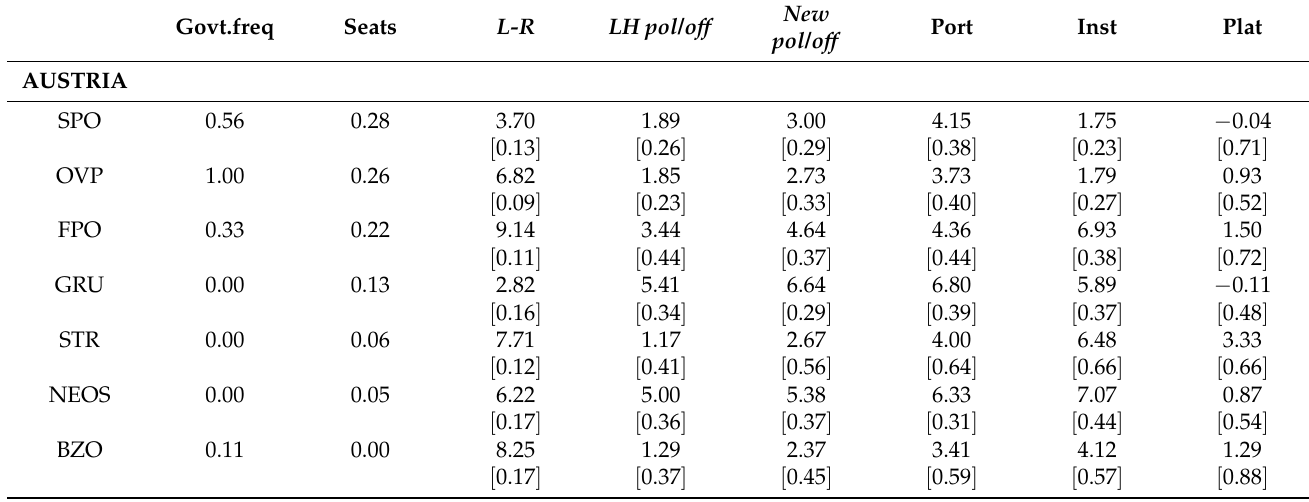
Table A1. Mean Ratings, Seats, and History in government.